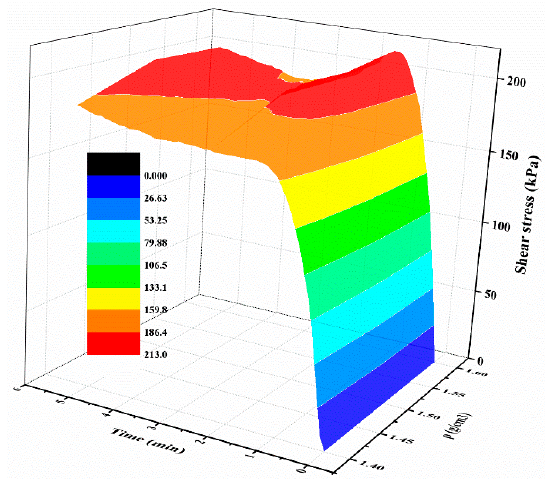
Figure 15. The relationship between shear stress, test time, and ρ .